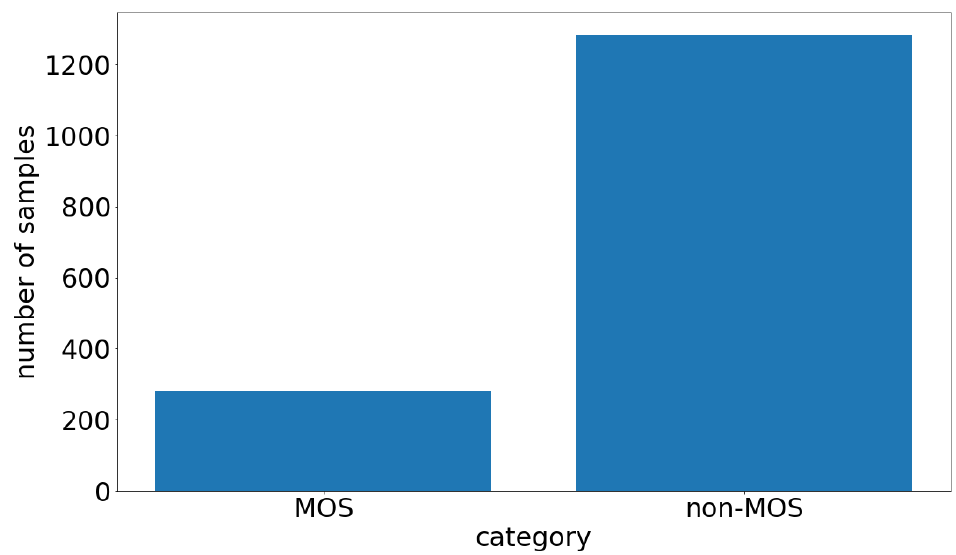
Figure 1. The label distribution of our physiological measurement dataset. The left bar is the Moment Of Stress (MOS) class, and the right one is the non-MOS